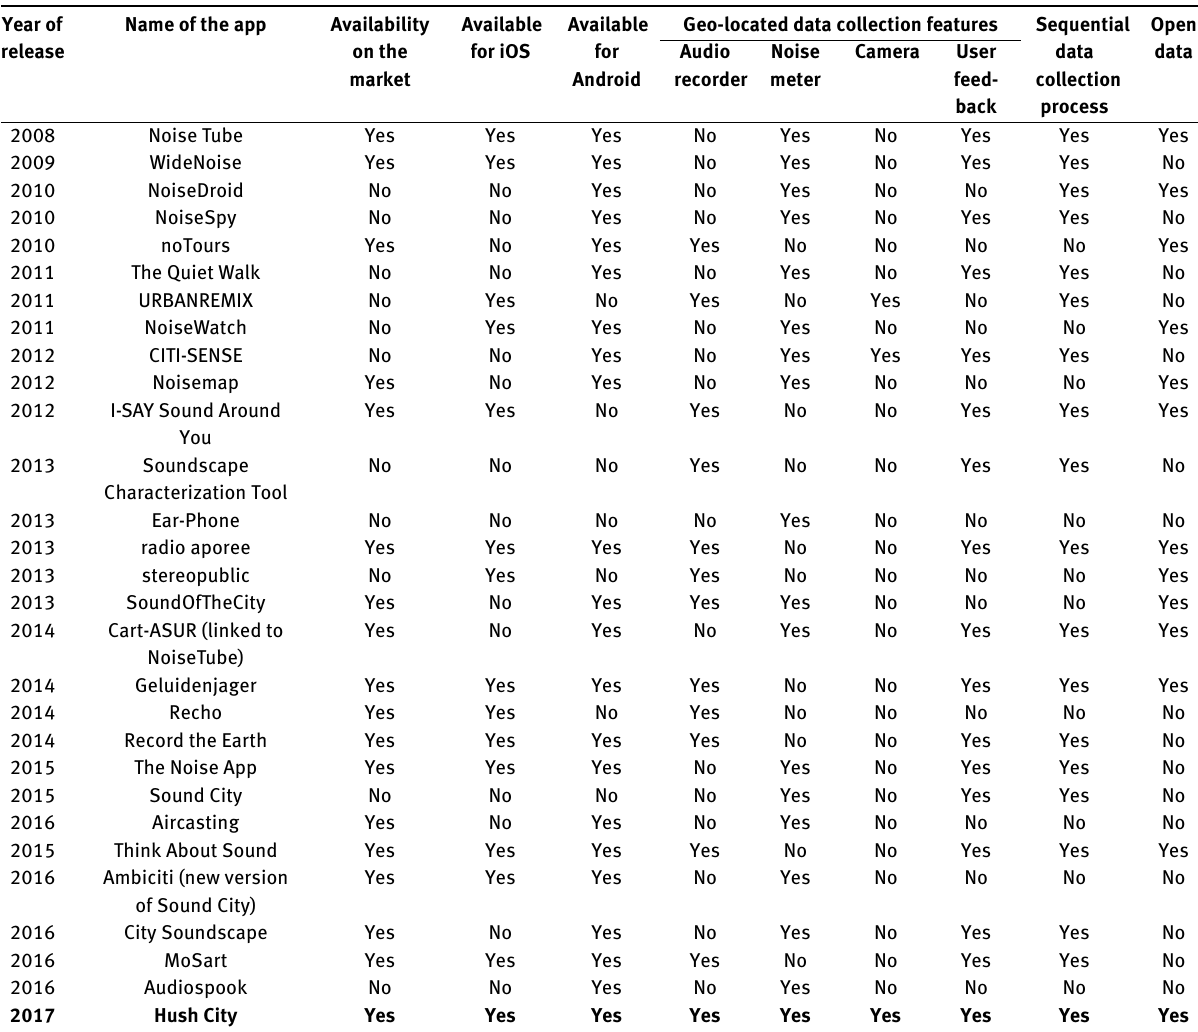
Table 1: State of the art of mobile applications for crowdsourced noise & sound maps conducted in-between June 2016 and October 2016 © A. Radicchi